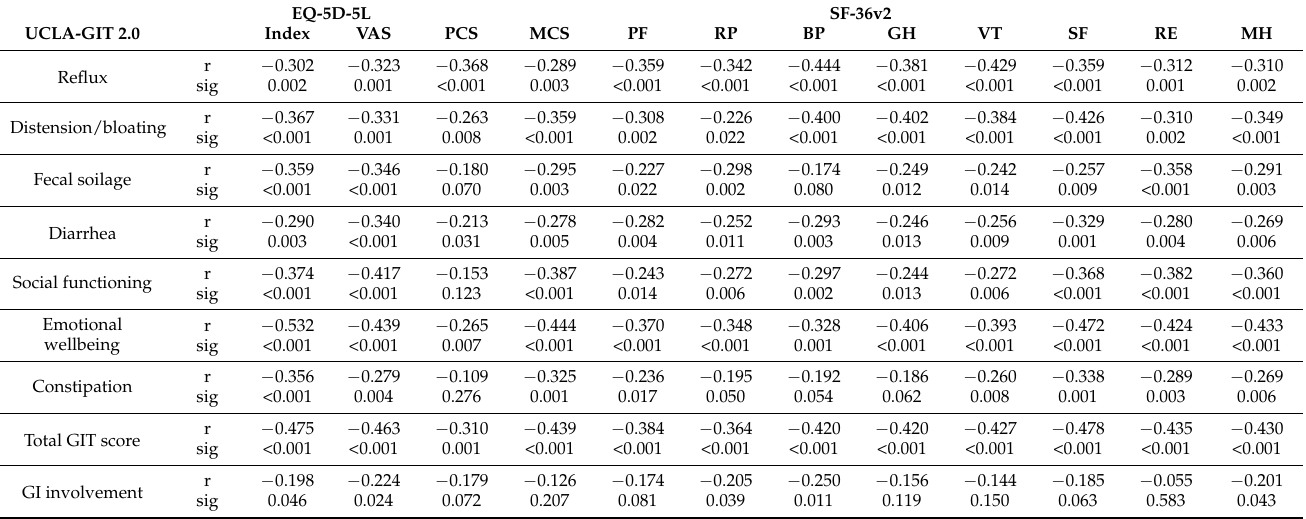
Table 7. Spearman’s correlation coefficients between UCLA GIT 2.0 and the EQ-5D-5L and SF-36v2